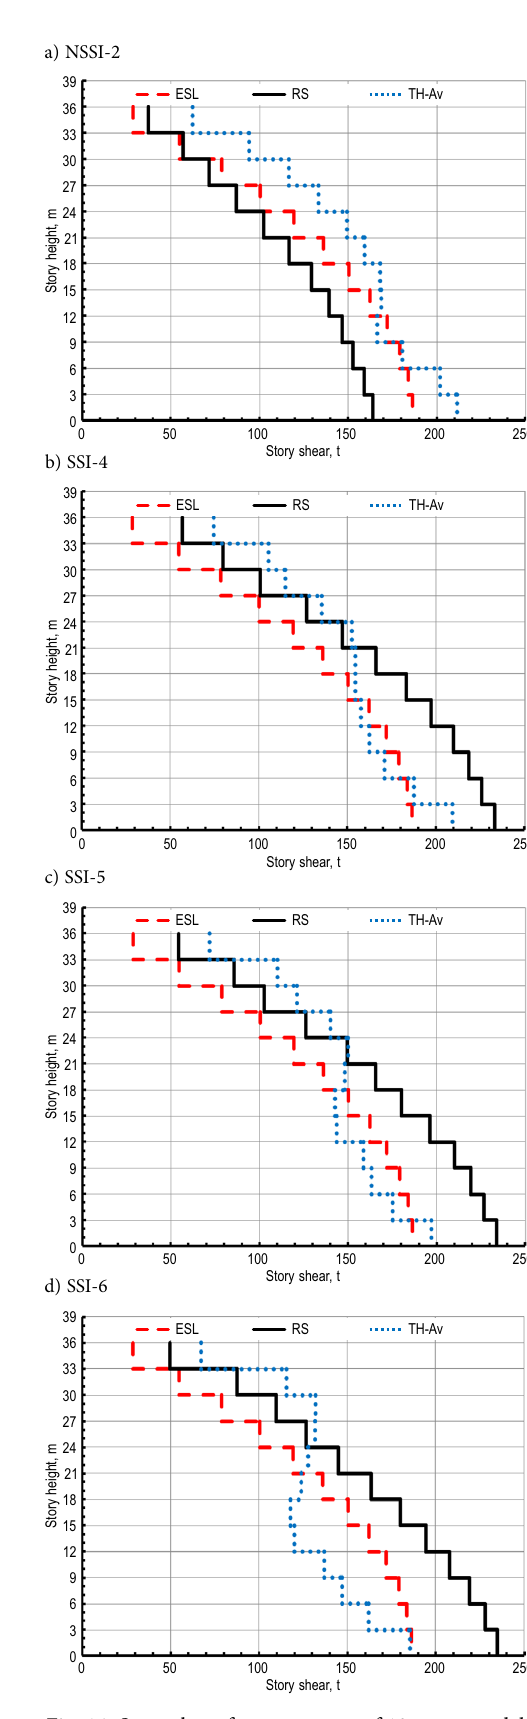
Fig. 14. Story shear force response of 12-story